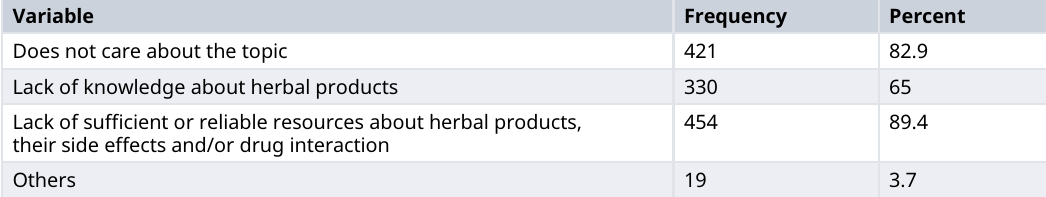
Table 4. Factors impeding the discussion of herbal products use with